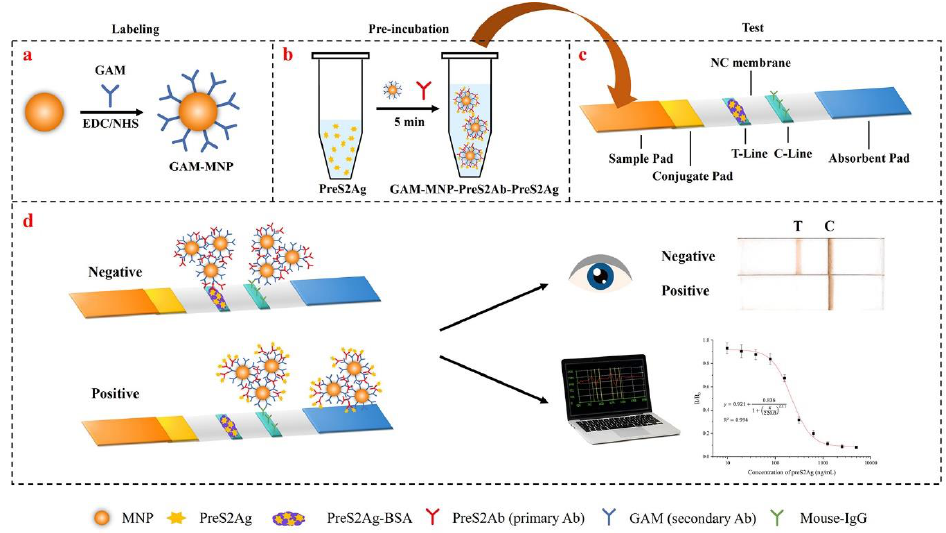
Figure 1. Schematic illustration of GAM-MNPs-ICA for preS2Ag detection. ( a ) Preparation of the GAM-MNP probe using the EDC / NHS method. ( b ) Pre-incubation of preS2Ag, preS2Ab, and GAM-MNPs. ( c ) Structure of the test strip. ( d ) Judgment of the negative and positive results and qualitative and quantitative analysis methods.